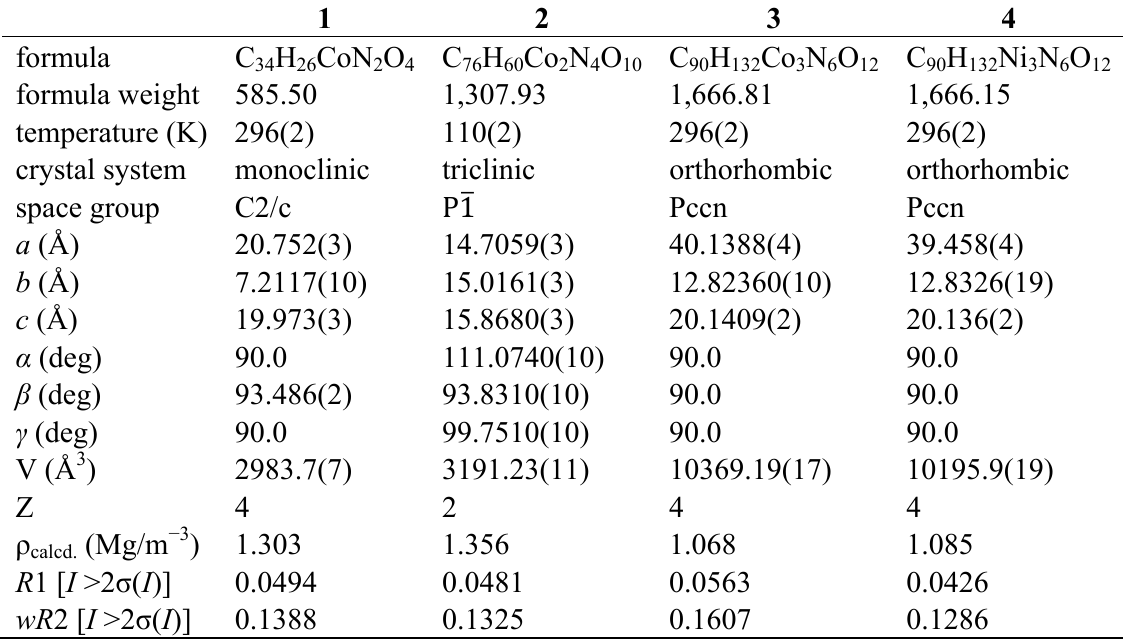
Table 1. Crystallographic data collection and refinement results for structures 1 – 4